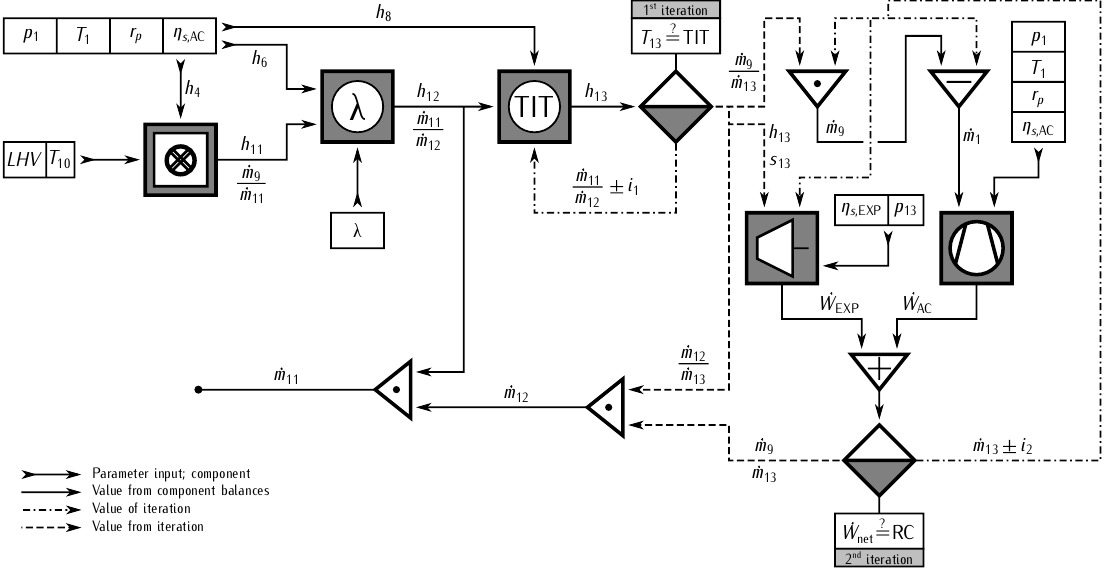
Figure 4. Calculation of mass flow rates in a gas turbine